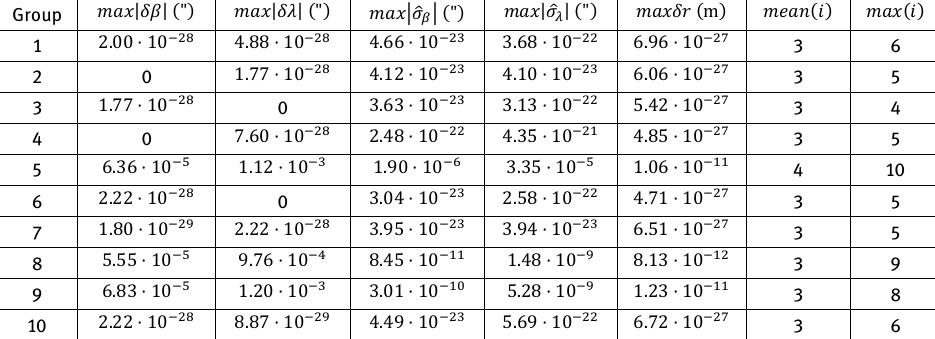
Table 4: Performance of the numerical method using quad precision